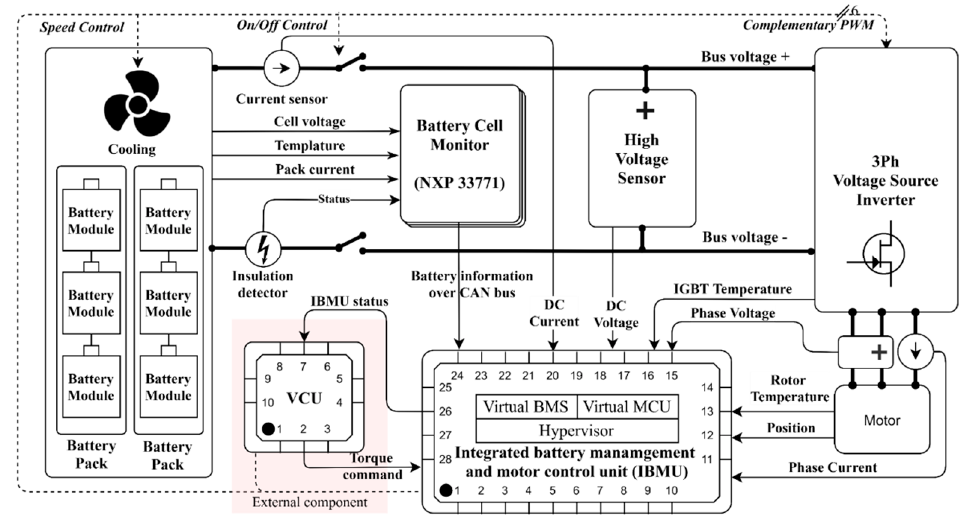
Figure 1. Proposed fail-operational architecture for IBMS. Table 1. Functional hazard analysis.